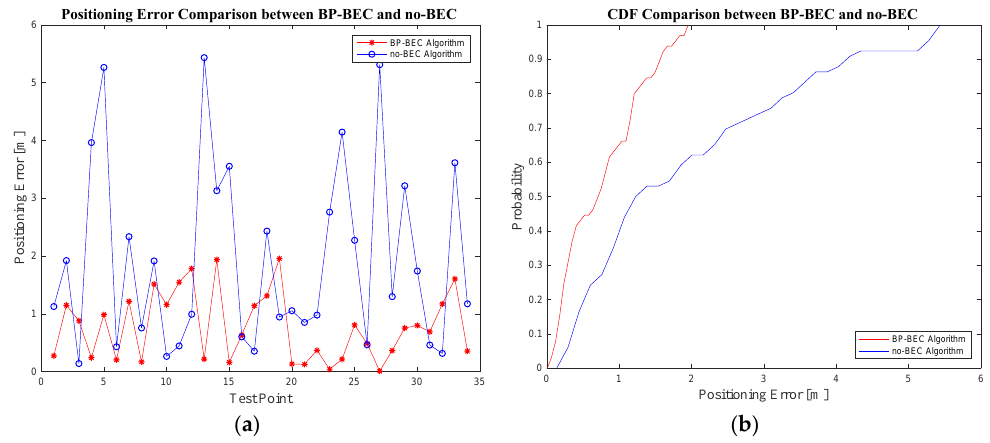
Figure 14. The comparison of positioning accuracy between the BP-BEC algorithm and the algorithm without body-shadowing error compensation (no-BEC): ( a ) positioning error comparison in scatter diagram; ( b ) positioning error comparison in CDF. Table 3. Positioning error comparisons between the BP-BEC and the no-BEC algorithms